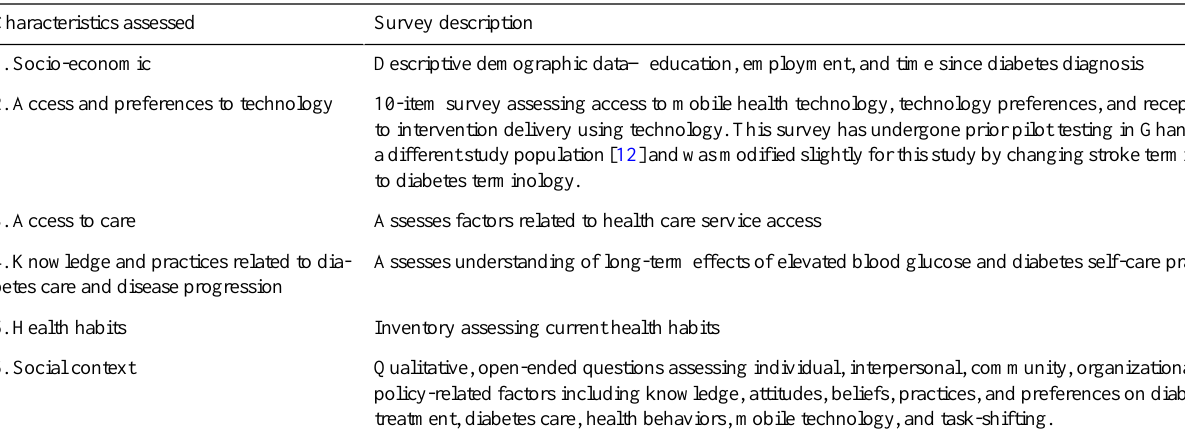
Table 1. Survey descriptions.